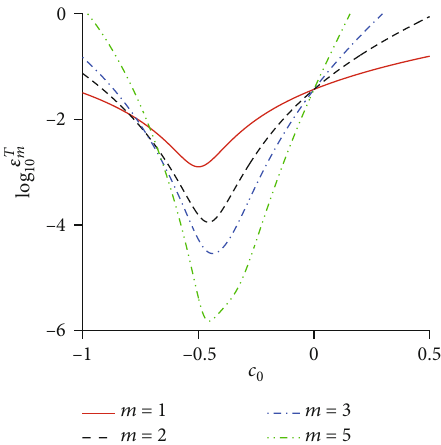
Figure 2: Residual squares of log approximation c